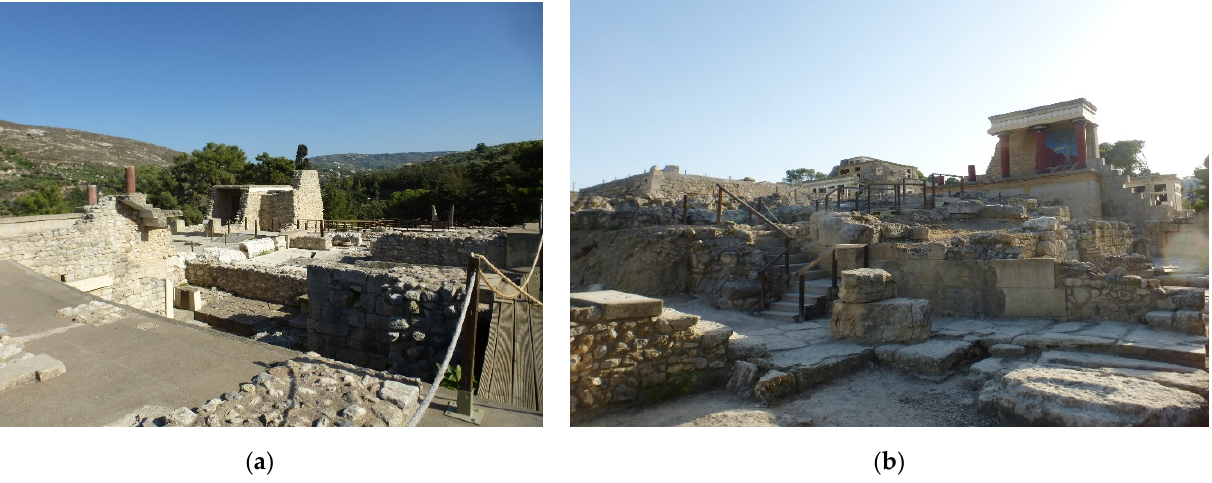
Figure 2. ( a ) Palace of Knossos, view of West Wings; ( b ) View of the north entrance (images: F.